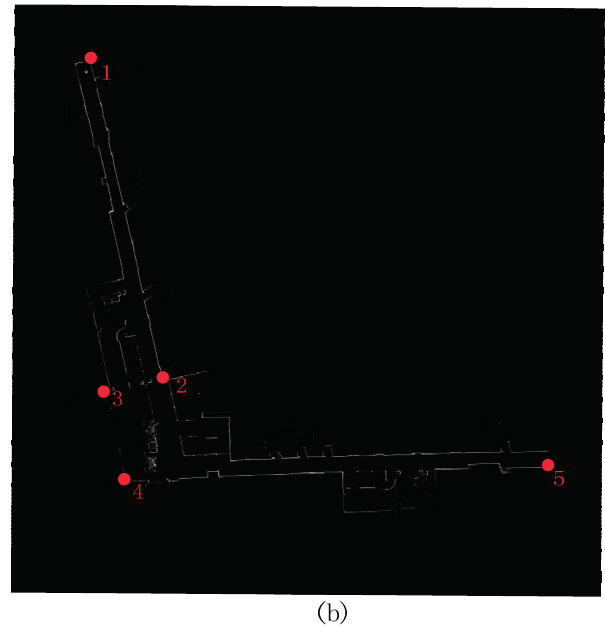
Figure 8. ( a ) The global coordinate map with control points for coordinate rectification; ( b ) example of a local coordinate grid map with control points.